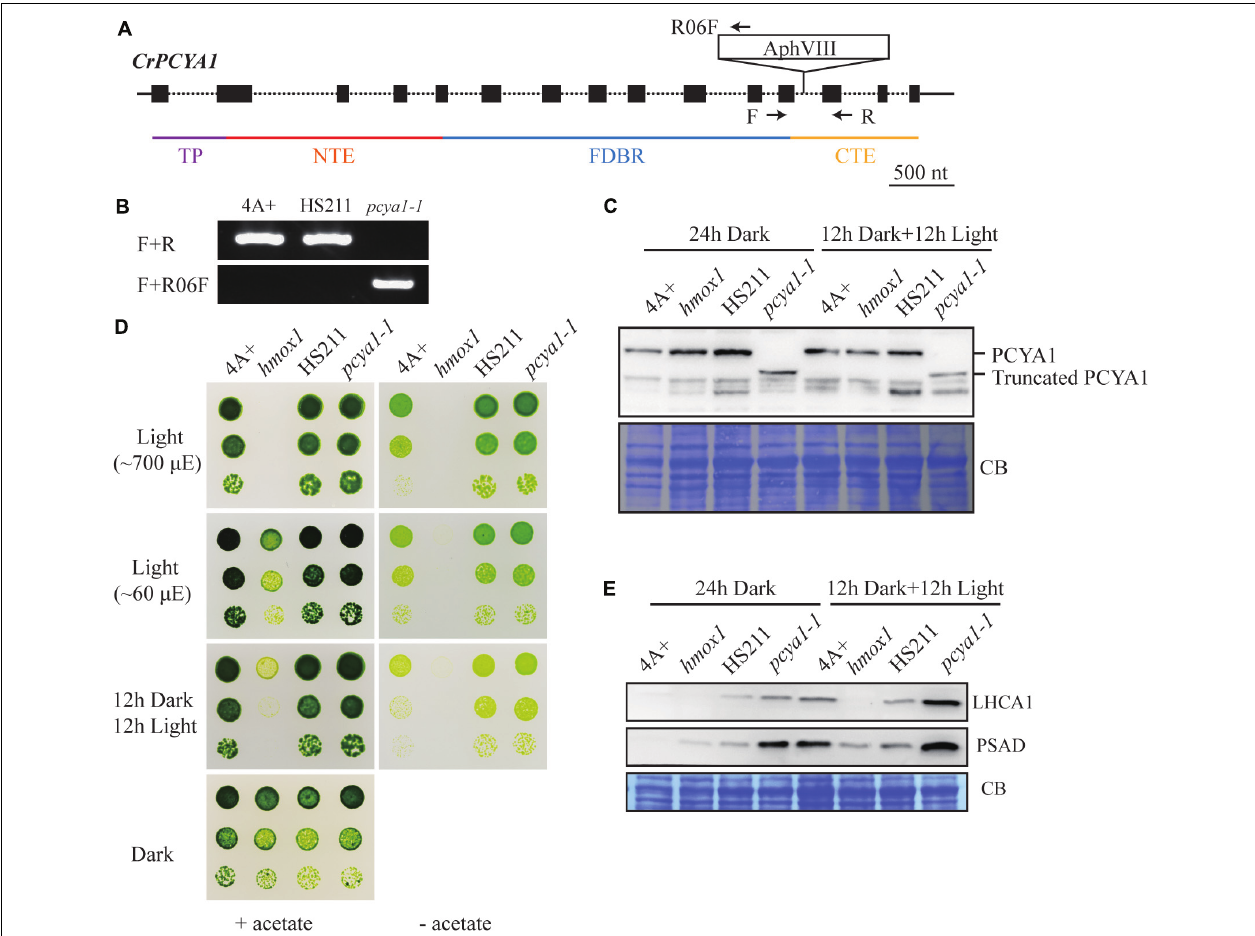
FIGURE 5 | Characterization of the CTE-disrupted pcya1-1 mutant. (A) Schematic diagram of an AphVIII insertion cassette into the PCYA1 locus in the pcya1-1 mutant. Black solid line represents 5 (cid:48) UTR and 3 (cid:48) UTR; black dotted line symbolizes intron; black box stands for exon and black arrows indicate the targeting sites of PCR primers. Purple, red, blue, and orange solid lines represent TP, NTE, FDBR and CTE regions of PCYA1, respectively. (B) PCR confirmation of the AphVIII insertion in pcya1-1 . Genomic DNA was extracted from 4A+, HS211 and pcya1-1 , respectively. PCR were performed using primers depicted in (A) . HS211, the parental strain of pcya1-1 . (C) Detection of CrPCYA1 expression in the dark or under light ( ∼ 160 µ mol photons m − 2 s − 1 ). Upper, immunoblot analysis of CrPCYA1 protein accumulation using antibody against CrPCYA1 mature protein; lower, Coomassie blue stain as an equal loading control. (D) Comparison of phototrophic growth phenotypes of pcya1-1 with 4A+, hmox1 and HS211 under constant low light ( ∼ 60 µ mol photons m − 2 s − 1 ), high light ( ∼ 700 µ mol photons m − 2 s − 1 ) and 12 h dark/12 h light cycle. (E) Accumulation of the photosystem I related proteins in pcya1-1 , 4A+, HS211 and hmox1 in the dark or under light ( ∼ 160 µ mol photons m − 2 s − 1 ). Immunoblot analyses were performed with LHCA1 and PSAD antibodies. Coomassie blue stain (CB) as an equal loading control. Approximately 30 µ g total proteins were loaded in each